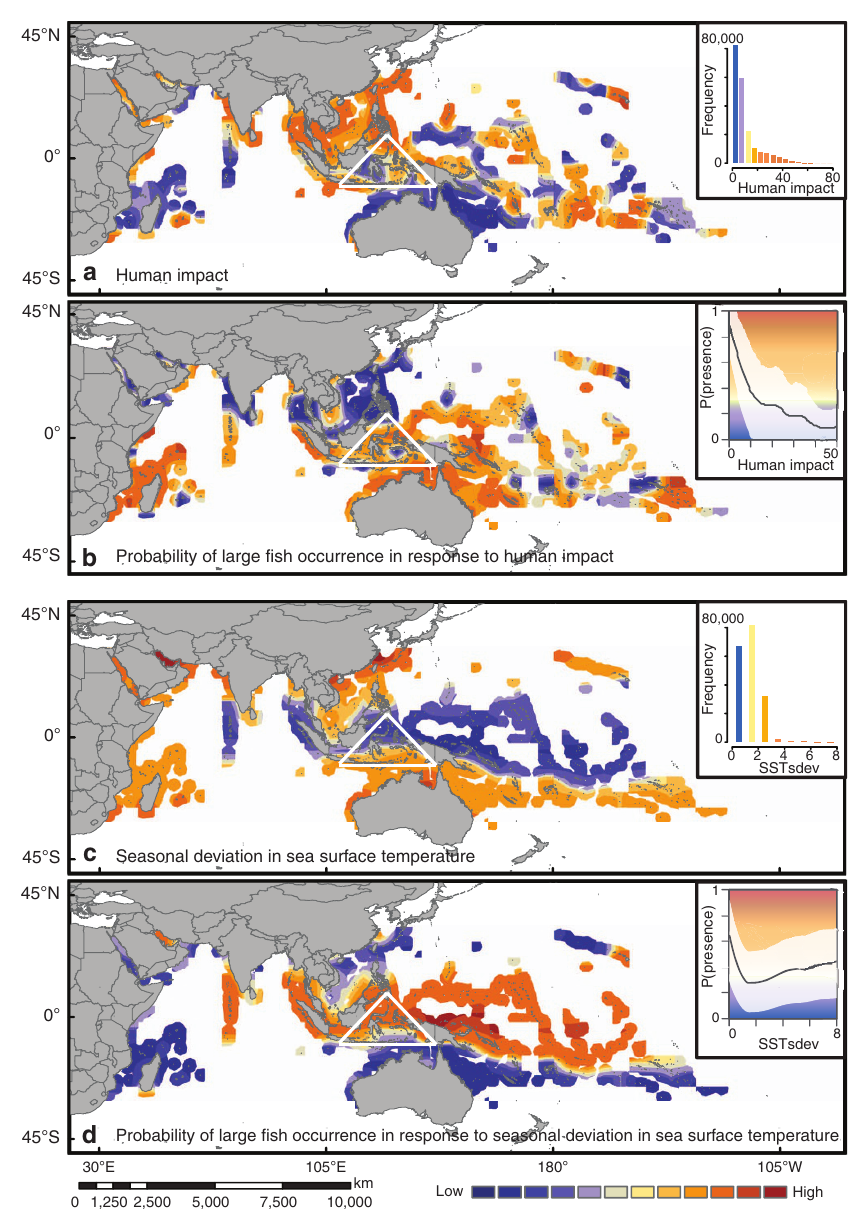
Figure 3 | Maps of human and climate seasonal variability, and predicted probabilities of large fish occurrence. ( a ) Human impact and ( b ) predicted probability of occurrence of large fishes (body size 4 50cm) within Indo-Pacific reefs in response to human impact; ( c ) Seasonal deviation (that is, seasonality) in sea surface temperature (SST sdev ) and ( d ) predicted probability of occurrence of large fishes in response to SST sdev . ( a , c ) Insets show the distribution of ( a ) human impact and ( c ) SST sdev across the study area. ( b , d ) Insets show the partial effect of ( b ) human impact and ( d ) SST sdev averaged across large fishes and the 95% confidence interval. The triangle indicates the location of the Coral Triangle. On each plot, the mid-point of the colour scale corresponds to the critical threshold in the mean effect across species (Davies test, P o Methods ranges 32 possible with minimal uncertainty around those estimates. We used an independent data set of expert-verified checklists 24 to delineate each species’ Fish occurrence data and biological traits . We obtained fish occurrence geographical range (convex hull, defined as the smallest convex polygon containing (presence/absence) data from 9,828 samples, of which 93% were transects and the all species records) as the basis for calculations of geographic range sizes (i.e., remaining point counts, from 906 locations of similar spatial extent within the extent of occurrence 23 ; in 10 6 km 2 ). For each species, we calculated range size Indo-Pacific (Supplementary Fig. 12; Supplementary Table 5). These data were (defined as the total area of the convex hull minus total land area) in ArcGis 10.0 collected by underwater visual census based on either fixed-length belt transects 52 using a global equal-area Behrmann projection. For each species, we also collated or stationary point counts 53 in shallow reef habitats (depth 0–30m), where all the following life-history traits 21,22 : trophic group, body size (i.e., maximum adult fishes sighted in the survey area were recorded on an underwater slate by divers. A total length, in cm), home range, mobility, diel activity pattern and schooling detailed description of the methods used for fish sampling is provided in behaviour. Some species were occasionally not sampled because two data sets Supplementary Table 5 and references therein. (WCS and PROCFish; Supplementary Table 5) used a restricted species list. This We selected 241 species from 10 families (Supplementary Data 1) for analysis resulted in 8% of all records missing; therefore, we did not use these records during based on the following criteria: (i) they satisfied minimum detection criteria (that is, we excluded cryptic and rare species, and those o 3cm total maximum length), model calibration and verified that missing data did not affect our analyses (see and (ii) they covered the broadest range of life-history traits 21 and geographical ‘Missing fish data’ section).